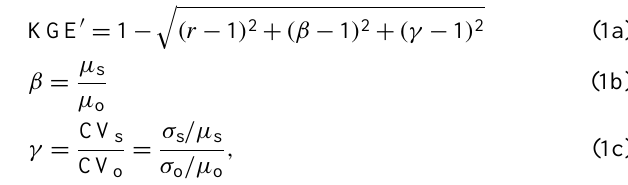
Table 3. LISFLOOD calibration parameters, including upper and lower bound. Parameter Description Unit Min Max UZTC Time constant for water in upper zone days LZTC Time constant for water in lower zone days 50 2500 GwPV Groundwater percolation value mmday − 1 0.5 2 GwLoss Maximum loss rate out of lower response box, expressed – 0.01 as a fraction of lower zone outflow b_Xinan Power in Xinanjiang distribution function – 0.01 PPrefFlow Power that controls increase of proportion of preferential – flow with increased soil moisture storage CCM Multiplier applied to Channel Manning’s n – TransSub Transmission loss function parameter – rnlim Normal reservoir storage limit (fraction) – rflim Food reservoir storage limit (fraction) rnormq rndq Normal